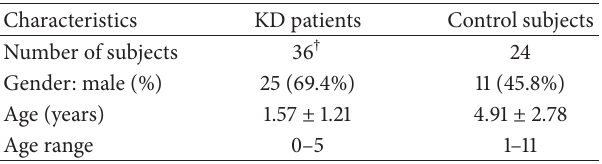
Table1:BasalcharacteristicsofpatientswithKawasakidisease(KD) and normal